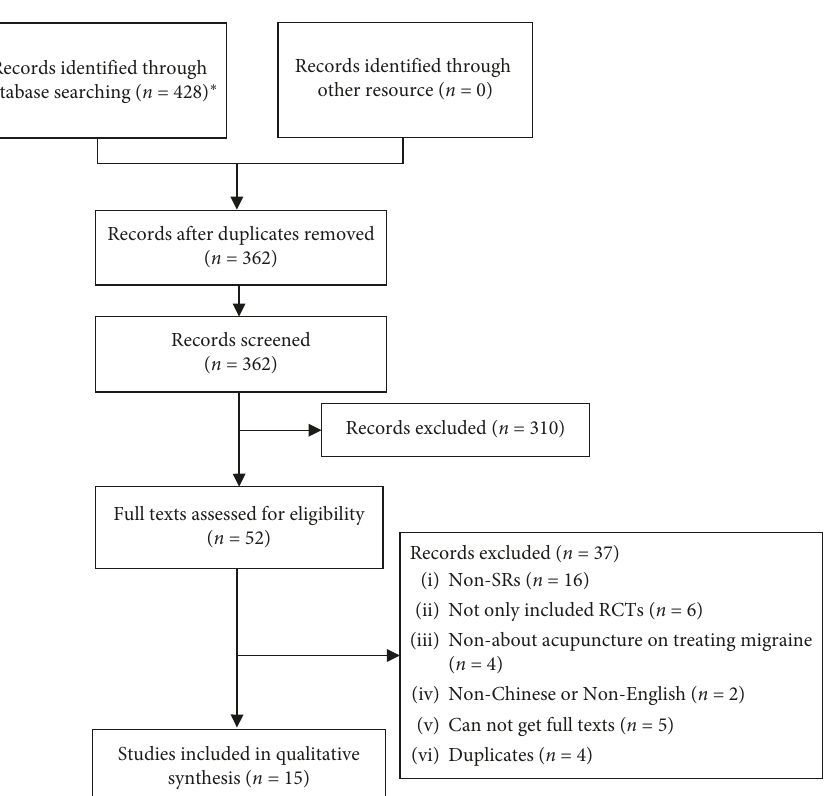
Figure 1: Studies selection for acupuncture treating migraine SR/MAs flow